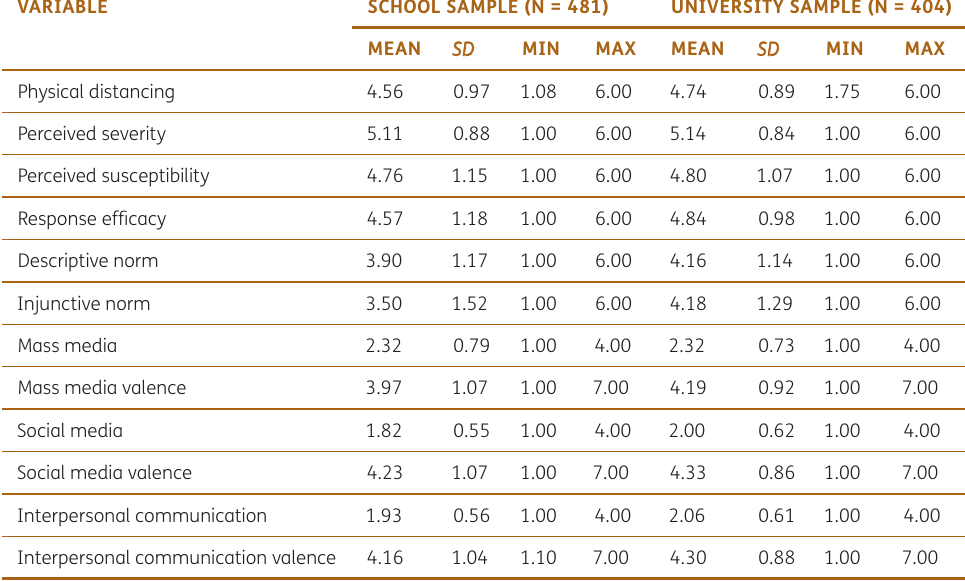
Table 1 Descriptives of Main Variables for the School and University